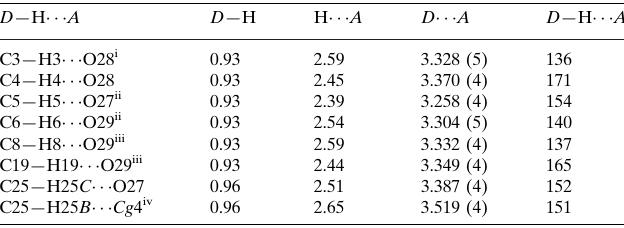
Hydrogen-bond geometry (A˚ , (cid:4) ). Cg 4 is the centroid of the C18–C23